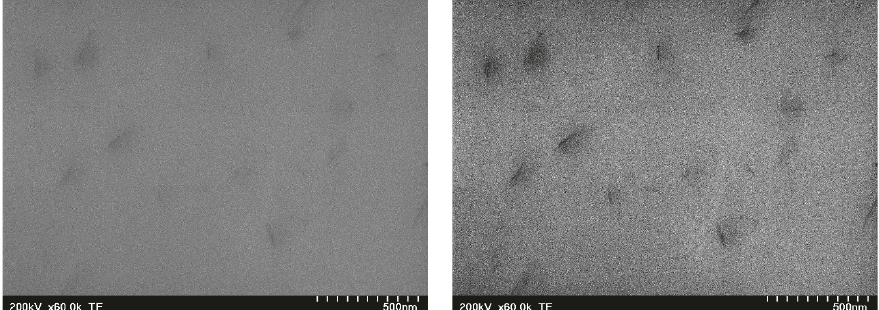
Figure 9: TEM micrographs of 2wt.% PET/ol-30B nanocomposite.